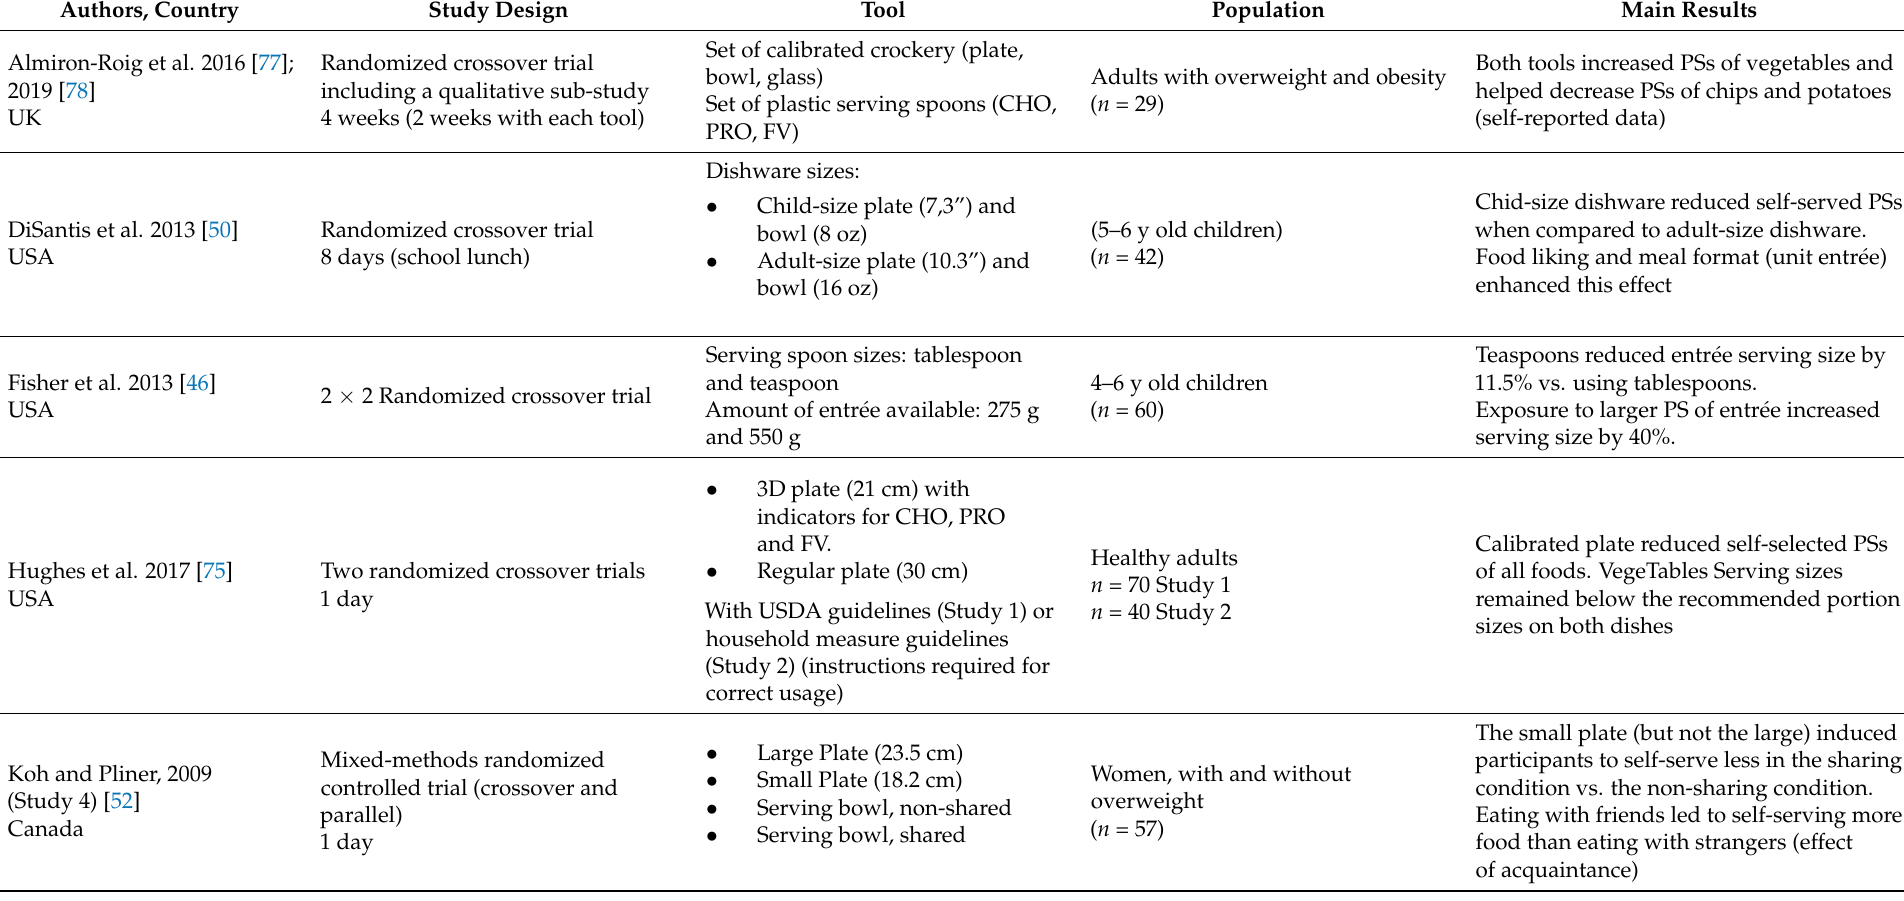
Table 4. Studies reporting changes in portion size choice (self-selected portion